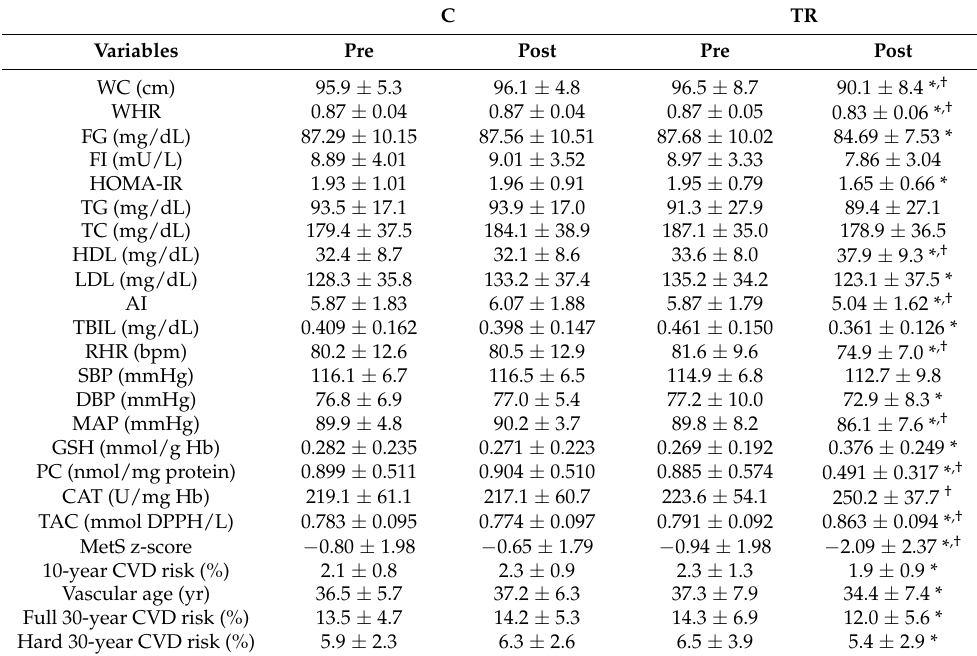
Table 2. Mean changes in cardiometabolic health, redox status, and oxidative stress indicators during 5 months of